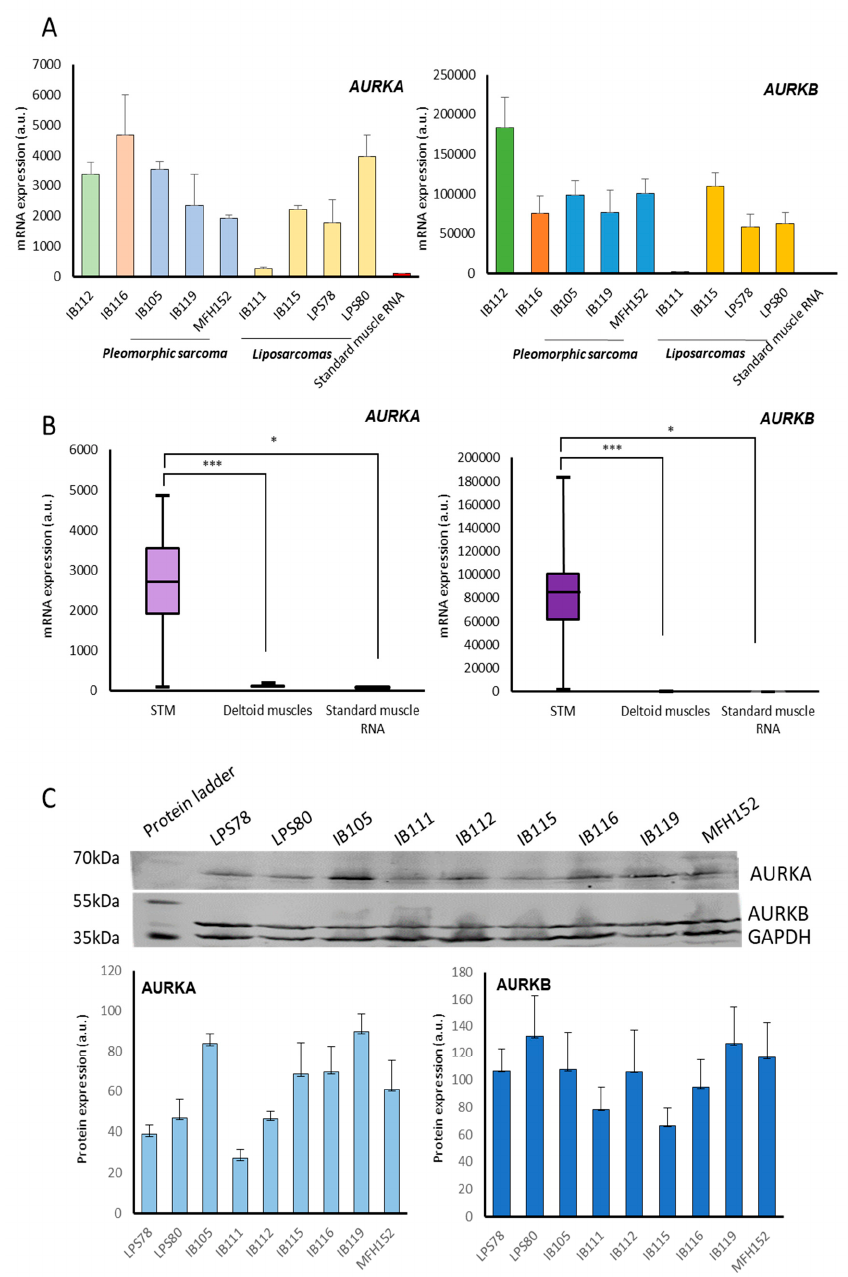
Figure 2. Characterisation of AURKA and AURK B expressions in STS cell lines and normal tissues. ( A , B ) Gene expression of AURKA and AURKB . After RNA extraction and reverse transcription, mRNA expressions are analysed by q-RT PCR. Expressions are normalized to the standard RNA. ( A ) Gene expression of AURKA and AURKB are compared in STM and a standard RNA. STS cell lines overexpressing mRNAs of Aurora kinases A (left) and B (right). ( B ) Gene expression of AURKA and AURKB are compared between STS cell lines, normal tissue from 10 deltoid biopsies and a standard RNA. Tumour cell lines still overexpressing mRNA of AURKA and AURKB . Histograms represent mean values of triplicate +/ − SEM. (*: p < 0.05; ***: p < 0.001). ( C ) Protein expression of AURKA and AURKB in STS. After protein extraction, AURKA and AURKB protein expressions were quantified by Western blot. The blot is representative of three independent experiments. Histograms represent mean of protein expression values normalized by GAPDH protein expression +/ − SEM. More details of western blot, please view at the supplementary